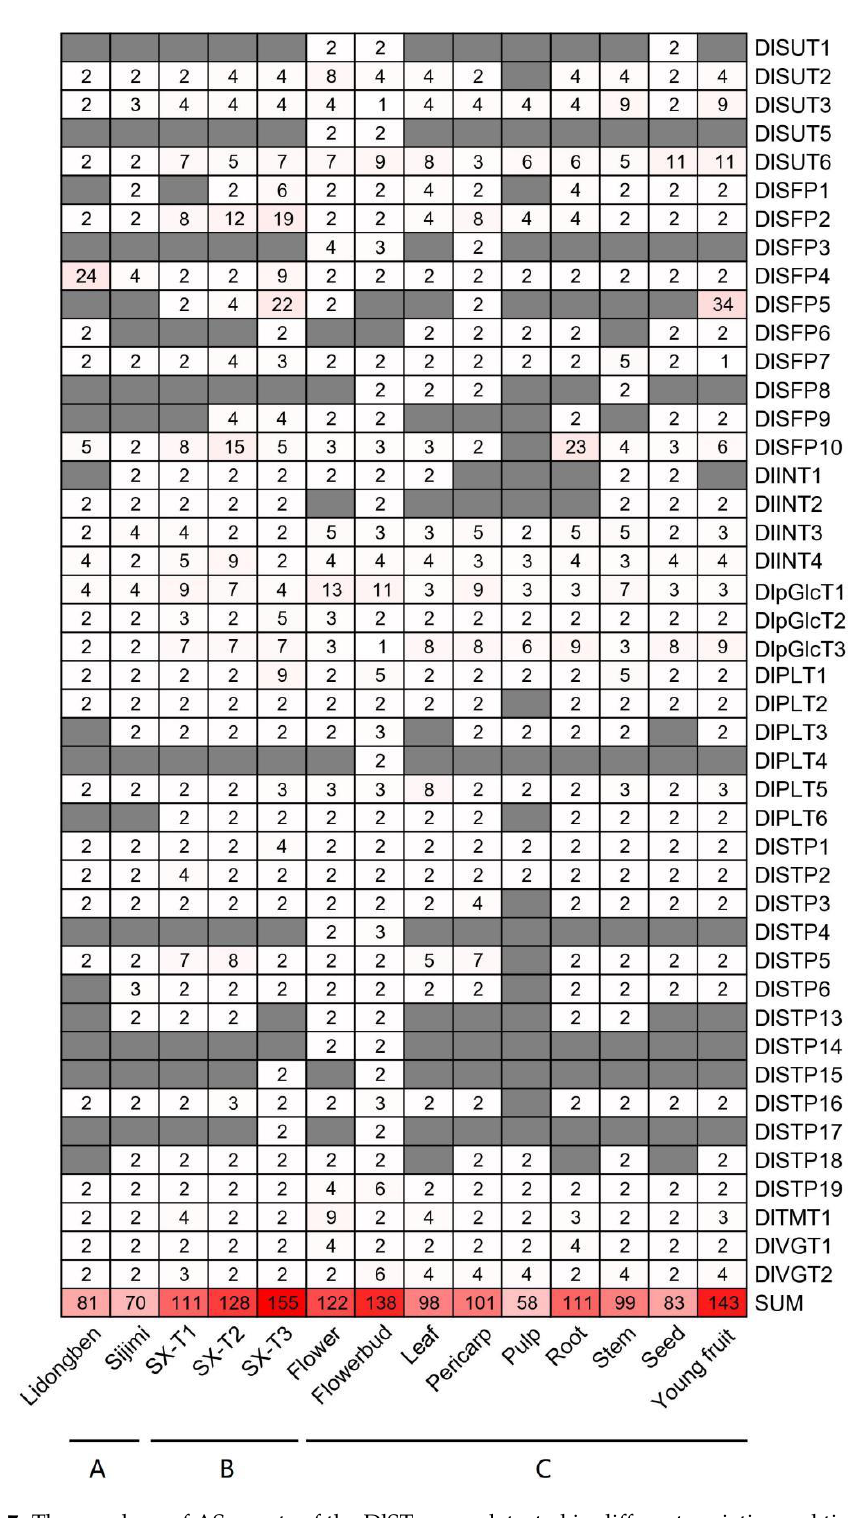
Figure 7. The numbers of AS events of the DlST genes detected in different varieties and tissues. ( A ) The AS events of the DlST genes detected in ‘Lidongben’ and ‘Sijimi’. ( B ) The AS events of the DlST genes detected in different floral bud development stages in ‘Shixia’. SX-T1 represent stage before the emergence of floral primordia, SX-T2 represent stage of the appearance of red dot, and SX-T3 represent stage of the appearance of the first inflorescence apical buds. ( C ) The AS events of the DlST genes detected in nine organs of ‘Sijimi’ clutivar.